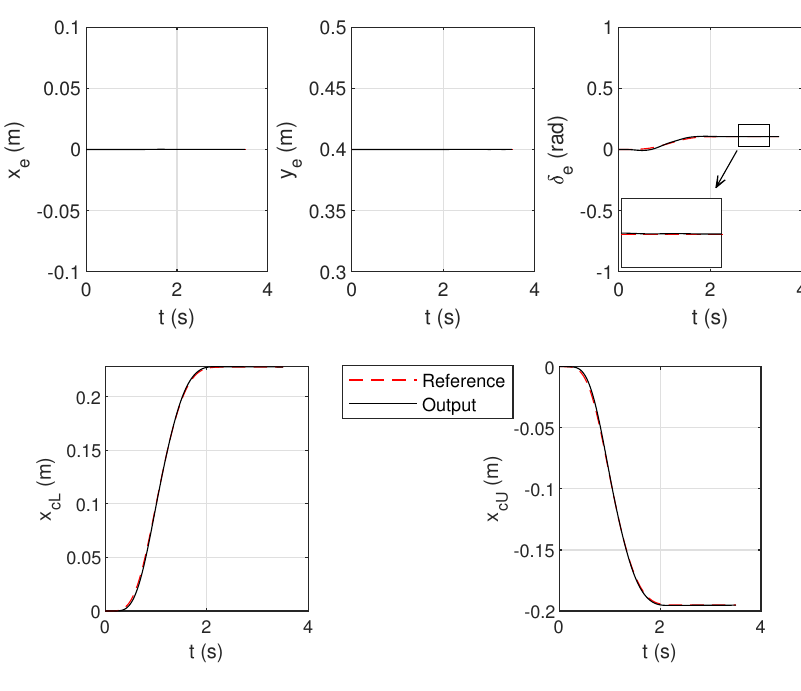
Figure 10. Case II